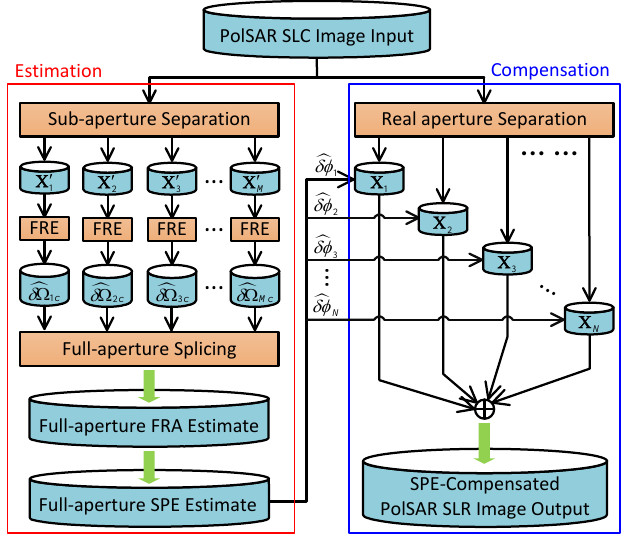
Figure 5. The flow chart of the processing scheme. At first, the sub-aperture separation strategy will be adopted to perform the FRE by using the B & B estimator, in order to obtain the local FRA estimate for each sub-aperture full-pol SAR image. Secondly, the full-aperture splicing is performed to retrieve the overall FRA and PS-SPE. The schematic diagram is illustrated in Figure 6, where (cid:99) δ Ω 1 c , (cid:99) δ Ω 2 c , · · · , (cid:99) δ Ω Mc are the local estimates of the FRA with the same coverage size in the PS plane. They are mutually overlapped to constitute a full-aperture PS region, and ∆ D ≈ L sub is the staggered distance of two neighboring sub-regions. The splicing operation as to (cid:99) δ Ω 1 c , (cid:99) δ Ω 2 c , taken for example, is given by an discrete expression, which is presented as